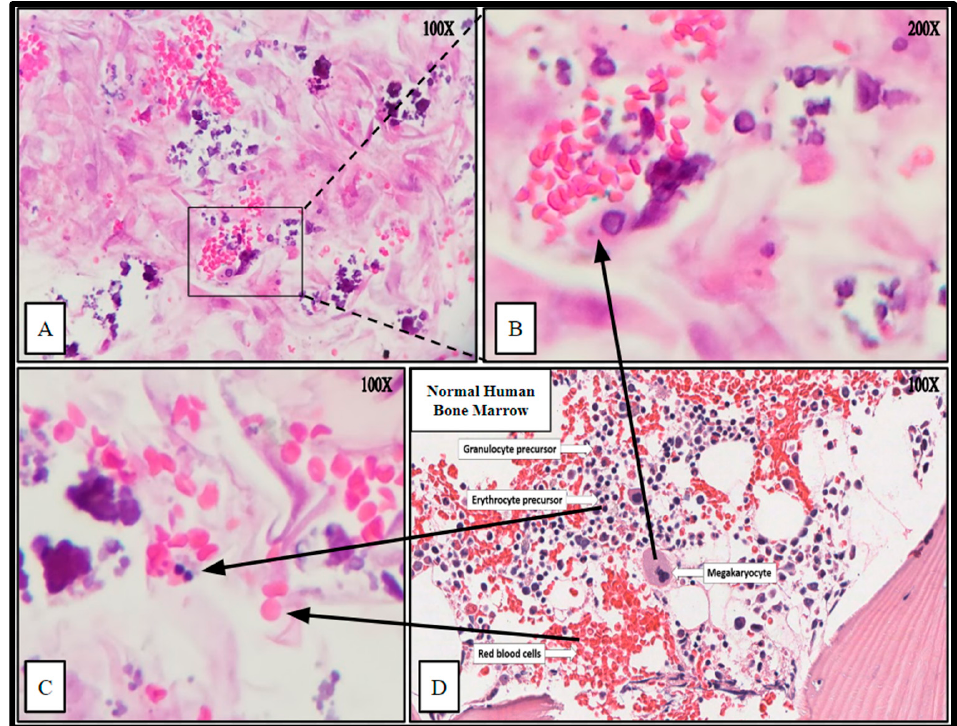
Figure 8. Hematoxylin and Eosin (H&E) staining of PCL scaffolding seeded with hBM cell popula- tion BM008 and cultured for 21 days in rotating shaker culture. Panels ( A – C ) demonstrate de-novo erythropoiesis and differentiation of the hematopoietic subset of the cultured primary hBM cells. Panel ( D ) is a representative image of normal human bone marrow. Arrows indicate histologic and cellular components observed in the seeded scaffolds and their corresponding presentation in the human bone marrow.